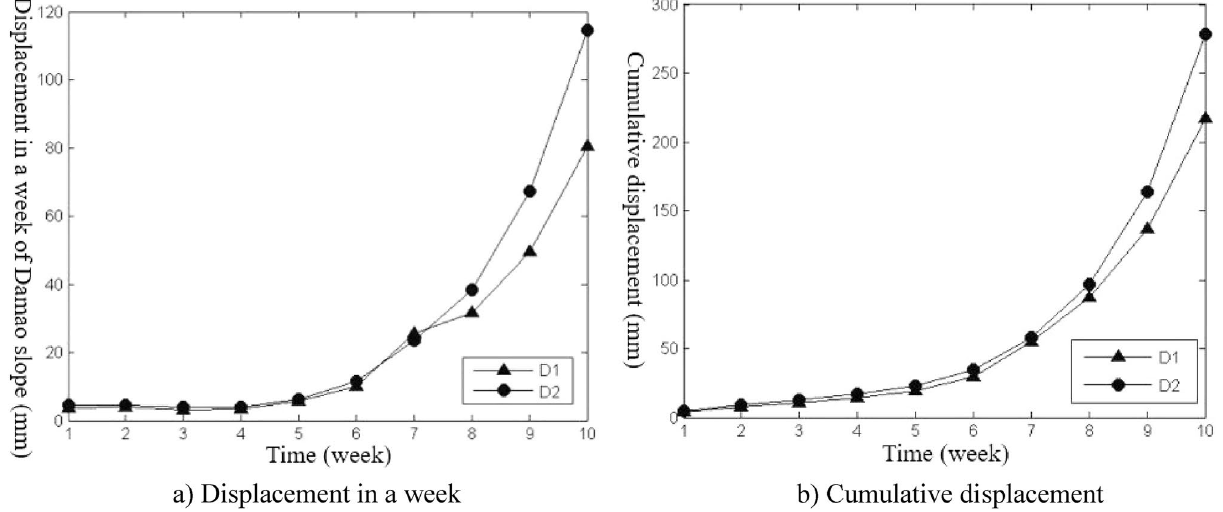
Figure 3. Displacement curves of monitoring points on the slope top from April 26 to June